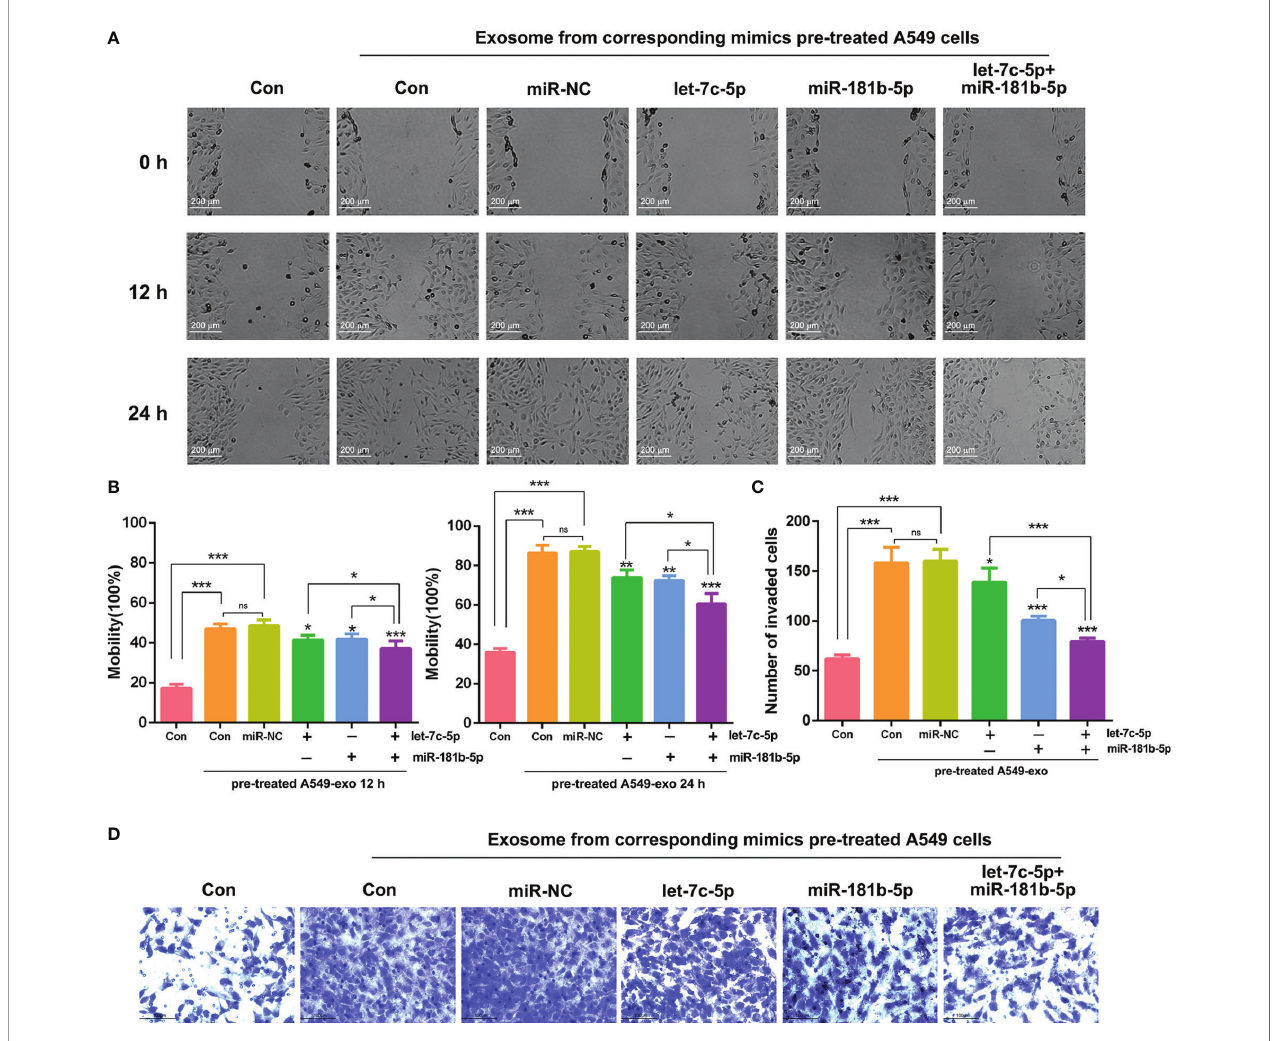
FIGURE 6 | Impact of exosomes from different treatments of A549 cells on migration and invasion of BEAS-2B cells. (A) Wound healing assay was used to identify the migration of BEAS-2B cells that were in fl uenced by exosomes derived from let-7c-5p/miR-181b-5p mimics pre-treated A549 cells for 0, 12, and 24 h. Statistical analysis of (B) mobility and (C) invasion ratio of BEAS-2B cells treated with let-7c-5p or miR-181b-5p high-expression exosomes, ns, no signi fi cance, * p <0.05, ** p <0.01, and *** p <0.001, and n ≥ 3. (D) Transwell assay was used to identify the invasion of BEAS-2B cells that were in fl uenced by exosomes from let-7c-5p or miR-181b-5p mimics-pretreated A549 cells. ns, no signi fi